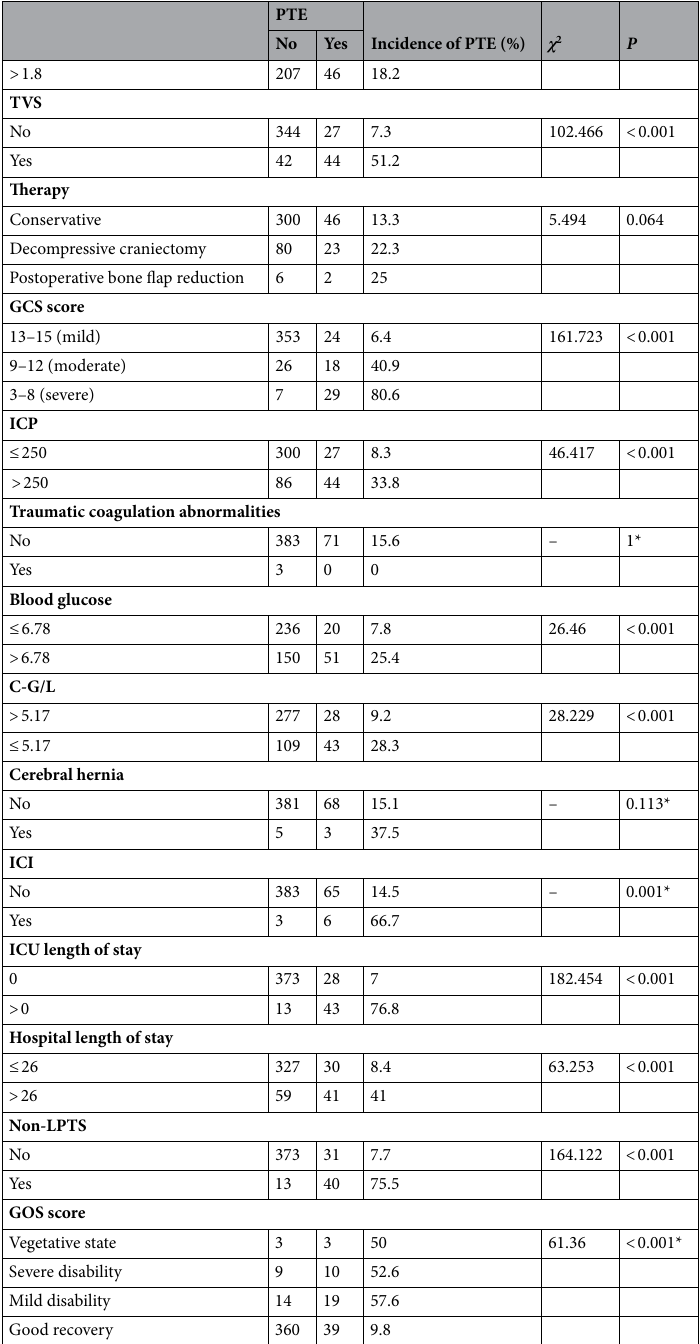
Table 2. Univariate analysis results (statistically significant). There were significant differences in the incidence of PTE between different Age, Sex, Contusion site, Chronic alcohol use, Contusion volume,